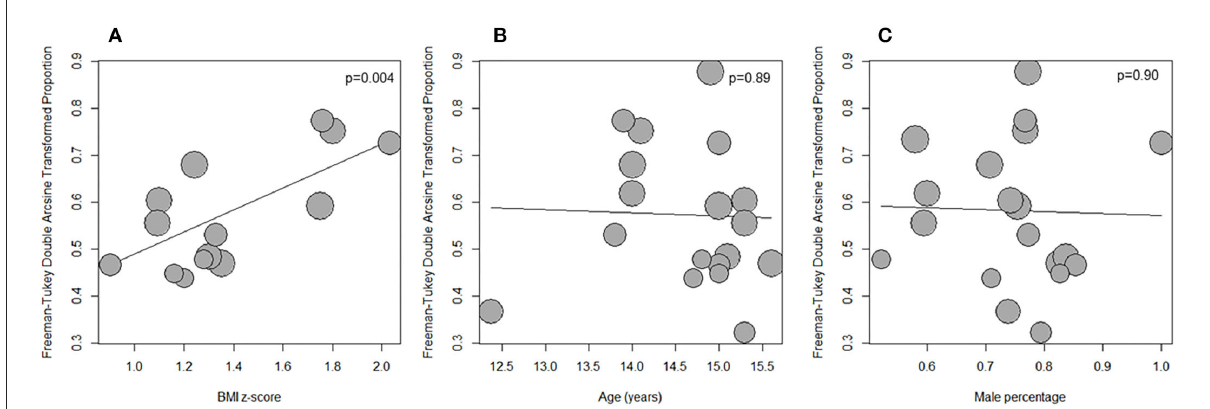
FIGURE5 Bubble plot showing the relationship between LVH prevalence and BMI z-score (A) , age (B) , and male proportion (C) in the subset of studies from specialtyclinics, LVH defined by ultrasound estimated LVMI 95th percentile and excluding subjects with WCH and/or preHT.